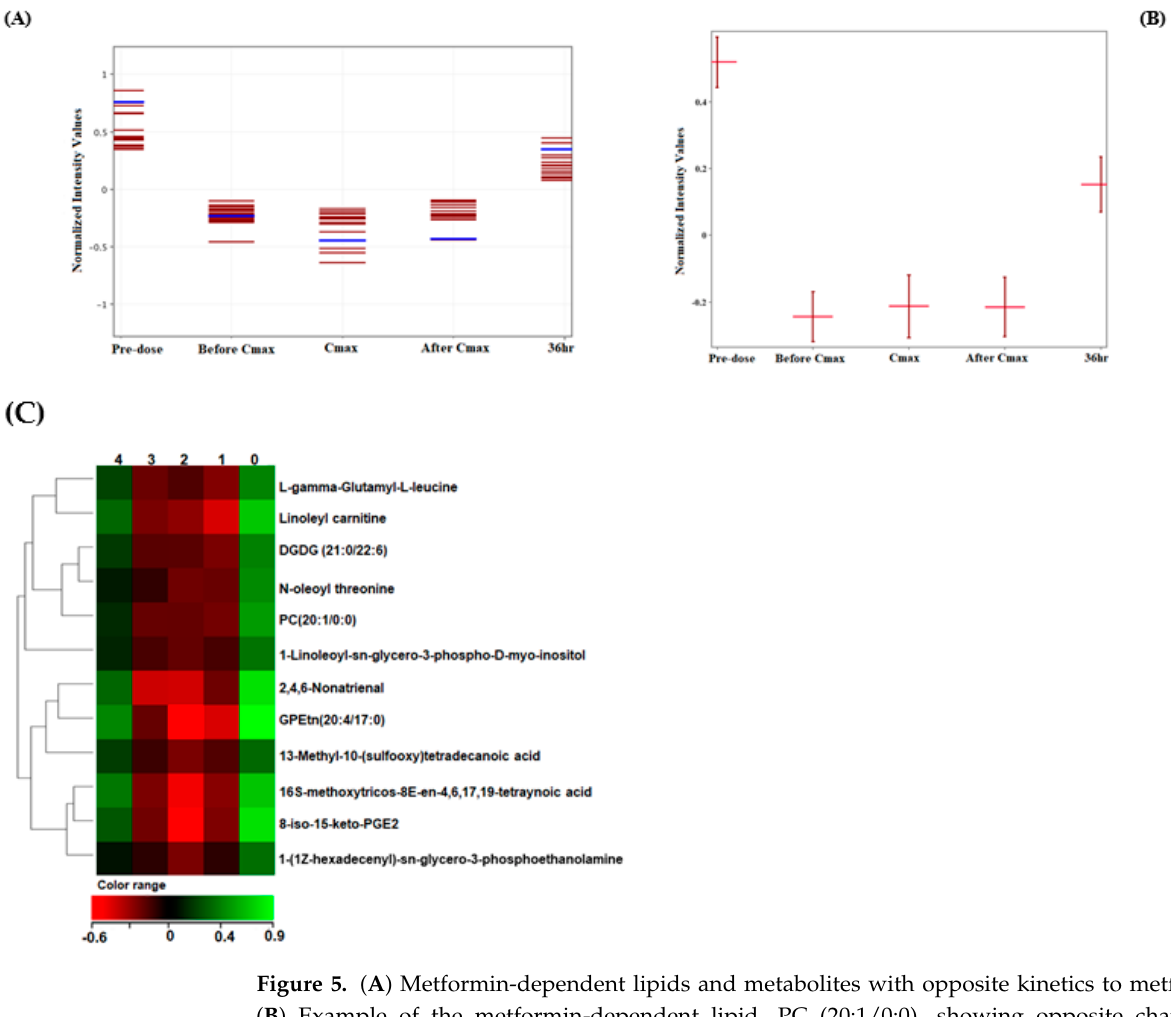
Figure 5. ( A ) Metformin-dependent lipids and metabolites with opposite kinetics to metformin. ( B ) Example of the metformin-dependent lipid, PC (20:1/0:0), showing opposite change in its level compared to metformin. ( C ) Hierarchal clustering (HAC) and heatmap analysis of 12 metformin − dependent biomolecules showing an opposed change in their level compared to metformin. Time points 0, 1, 2, 3, and 4 refer to predose, before Cmax, Cmax, after Cmax, and 36 h post − metformin administration.